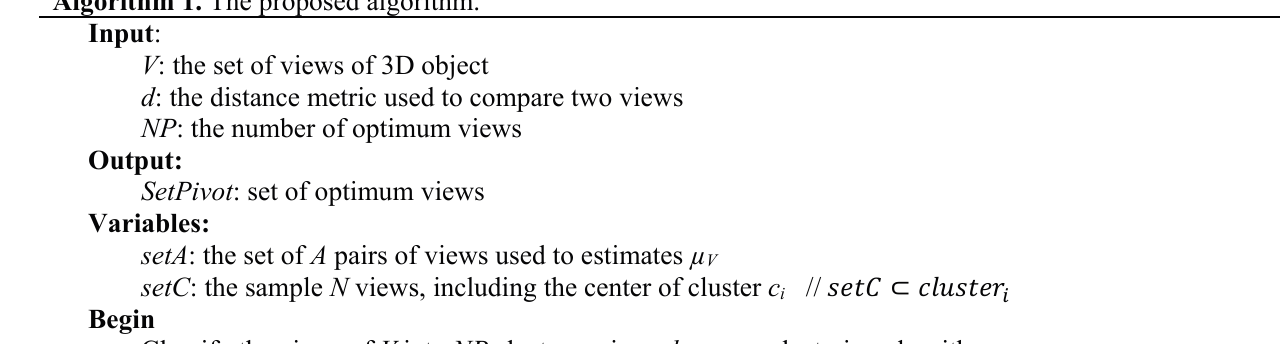
Algorithm 1. The proposed